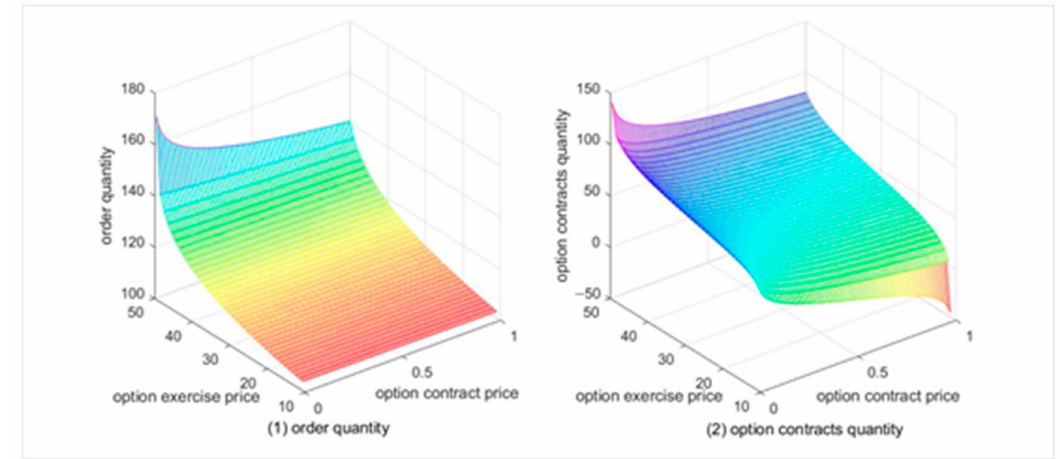
Figure 3. Retailer’s independent